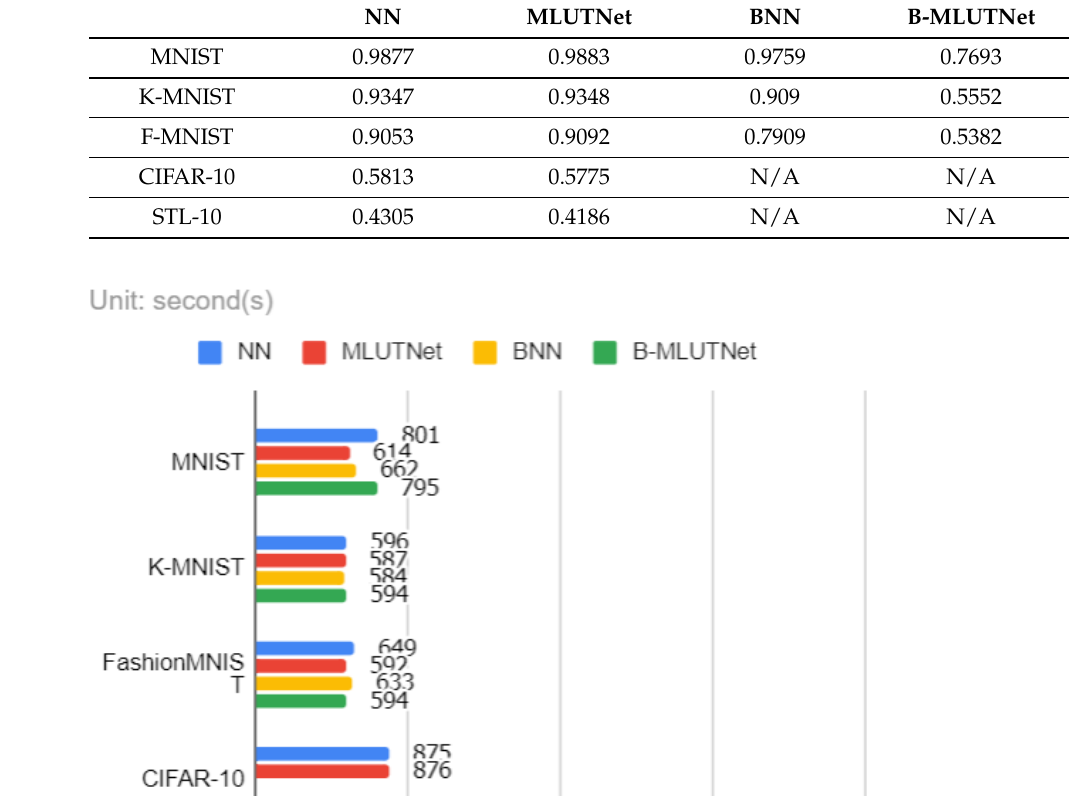
Table 1. Optimal accuracy performance.